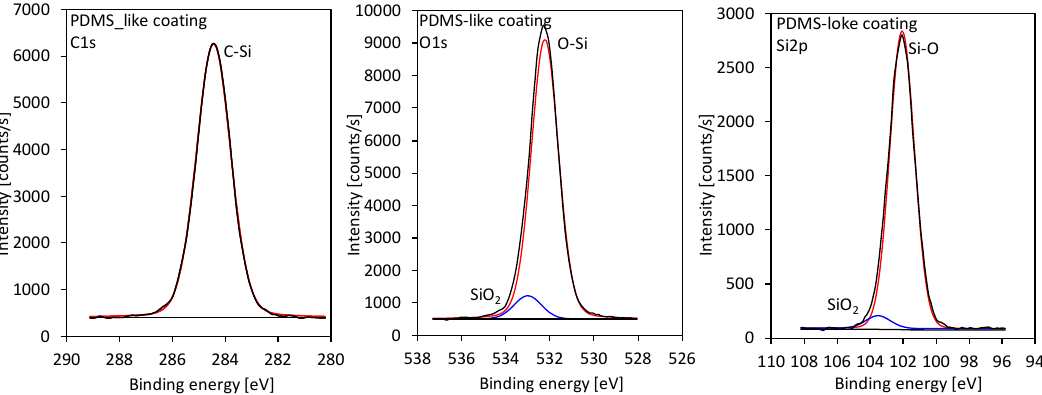
Figure 10. High-resolution X-ray photoelectron spectroscopy (XPS) spectra of carbon C1s, oxygen O1s, and silicon Si2p for the deposited coating.